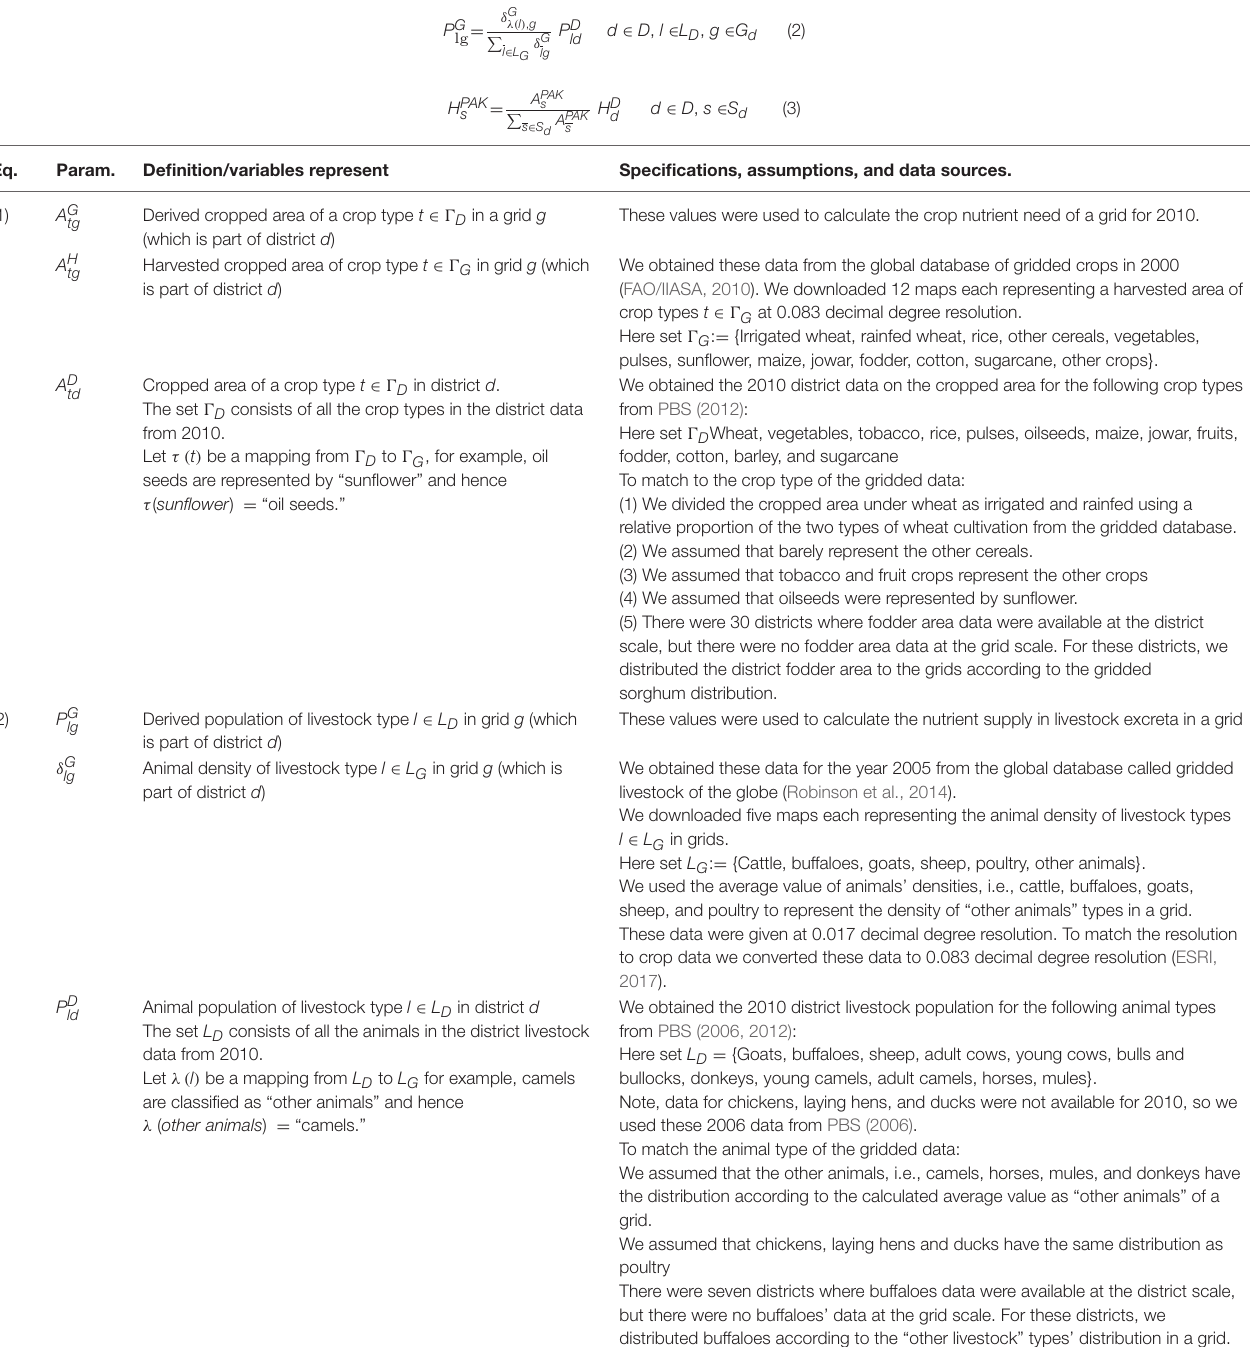
TABLE 1 | Equations, data, and assumptions used to transform Pakistan low-resolution district cropped area, livestock, and human populations to higher resolution gridded data. We overlaid the district data maps and the gridded data maps using ArcMap 10.3.1. We used the center points of grids to allocate grids to a district in order to avoid duplicate values of grids in more than one district. We used Equation (1) to convert the 2010 district cropped area into the gridded cropped area. We used Equation (2) to convert the 2010 district livestock population into gridded livestock populations. We used Equation (3) to convert the 2010 district human population into the populations in human settlements. Note, we used the proportional distribution equations independently for each crop or livestock type and then aggregate these data values in each grid. That means each grid can thus contain multiple crops types as well as multiple livestock